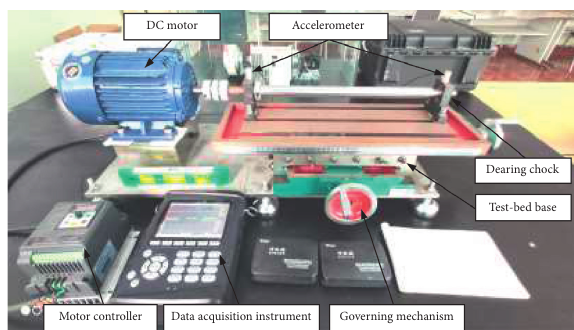
Figure 12: Full life cycle performance degradation test bench.